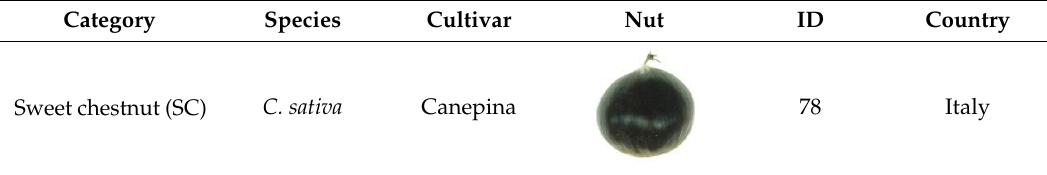
Table 1. Origin and identification codes (number of the tree in the orchard) of the sampled raw material.